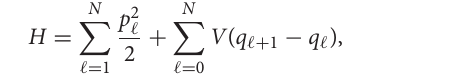
q ℓ and p ℓ , for ℓ 1, 2, . . . , N . One often starts with the =